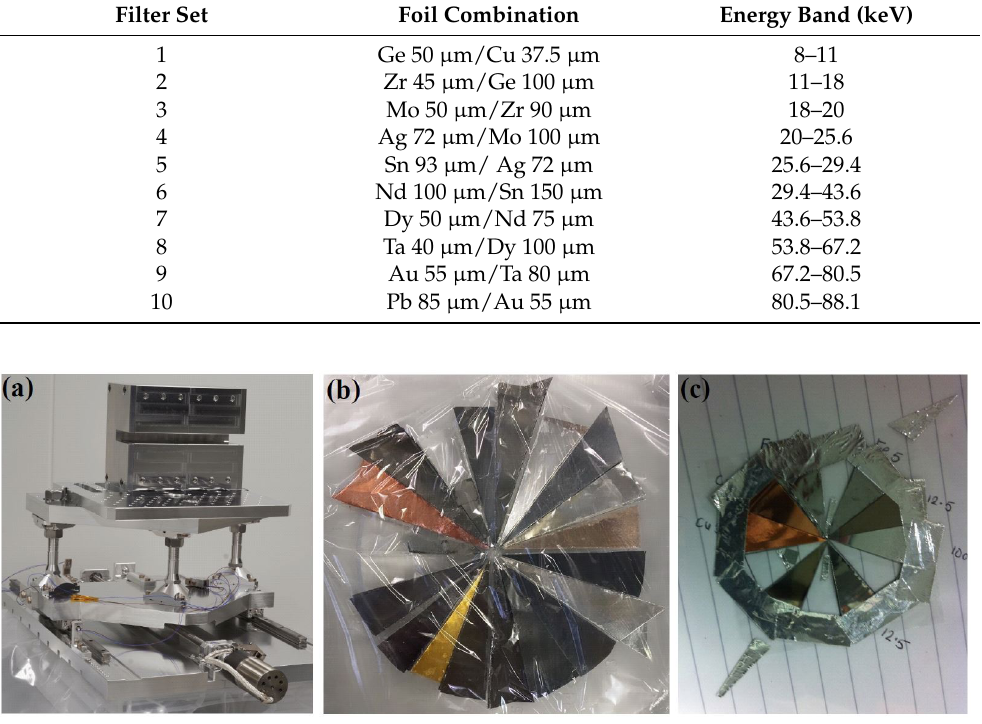
Figure 9. ( a ) A 20 cm long electron spectrometer with the dipole magnet on a motorized base. The ES has a 20 mm gap with a uniform magnetic field of about 1 T at the center of the gap. ( b ) The ELI high-energy Ross-filter-based spectrometer (spectral range: 8 keV to 88 keV) consisting of 10 filter pairs made of 18 metallic foils. ( c ) Ross-filter pairs employing 9 thin filters to cover the lower spectral energy range (3–20